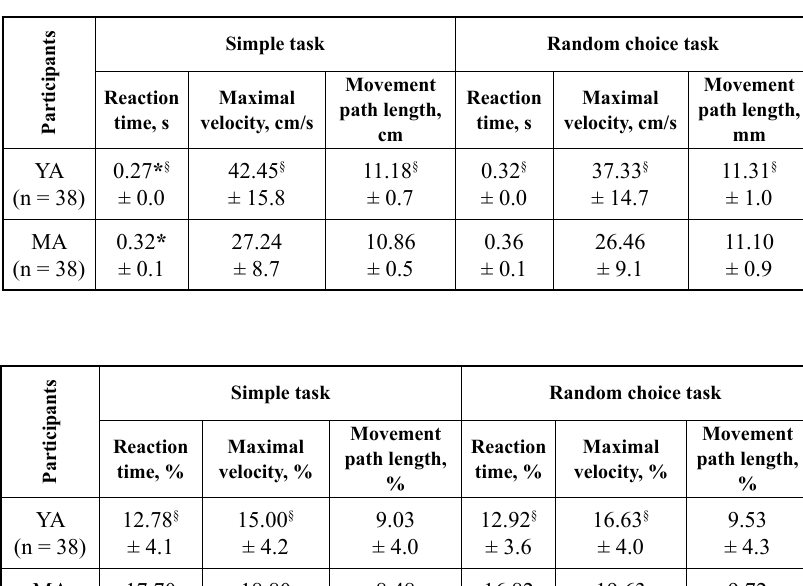
Note. MA – middle-aged adults; YA – young adults; § – difference statistically significant at 0.05 level as compared with values between different age